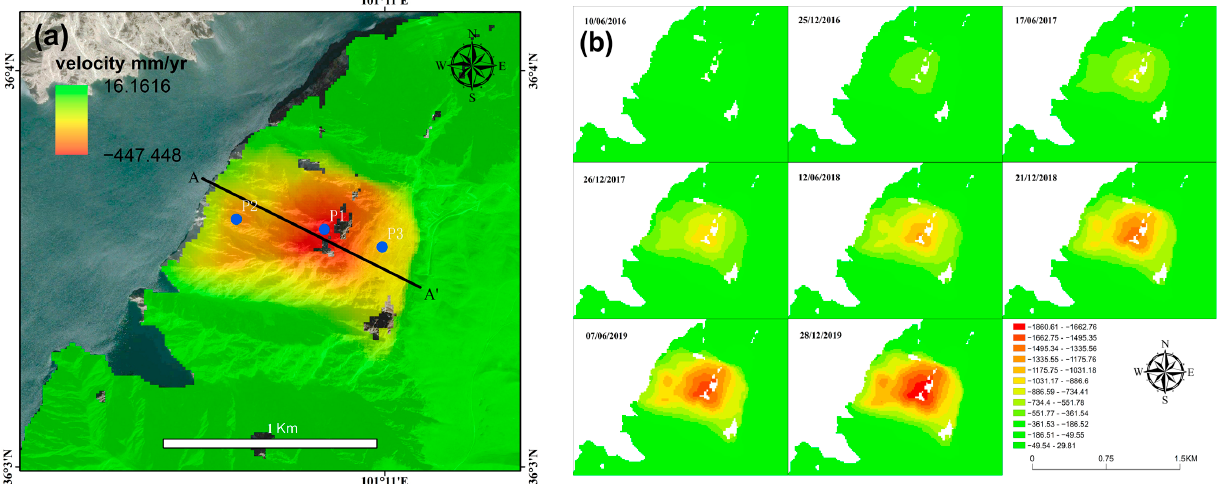
Table 2. The annual cumulative deformation during the monitoring period.